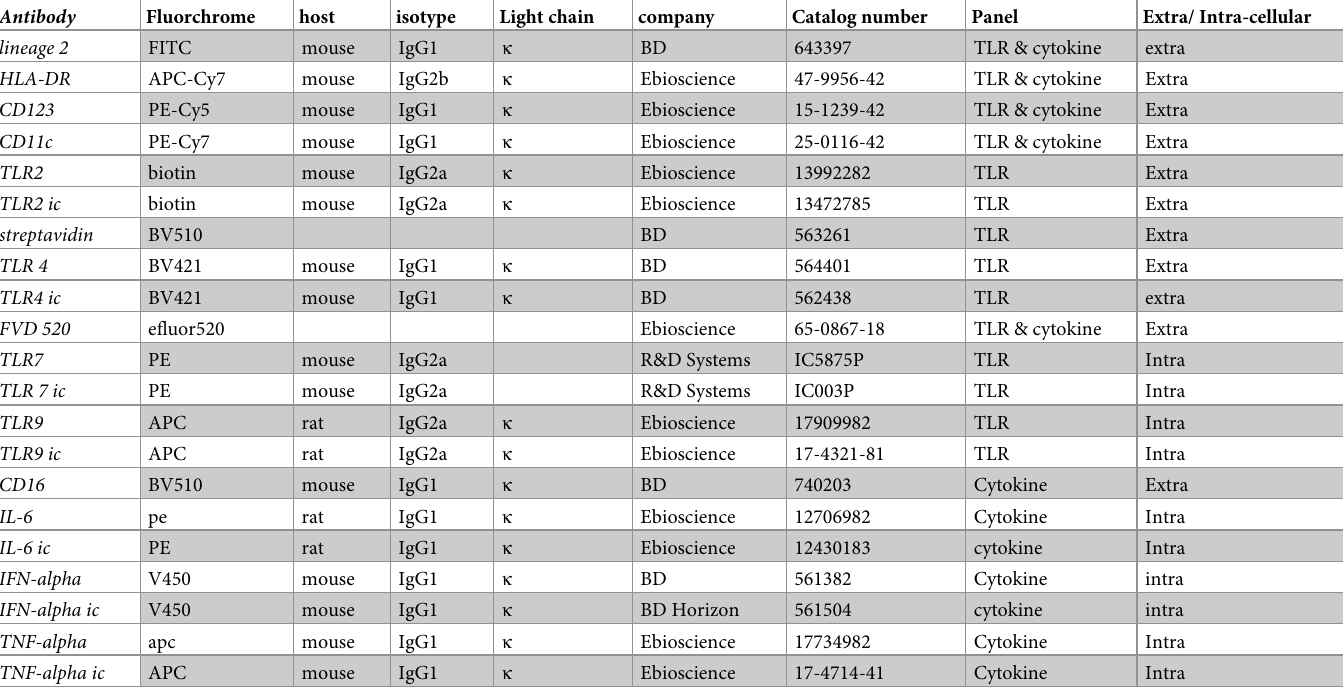
Table 2. Antibodies used for TLR expression and intracellular cytokine measurements. Antibody